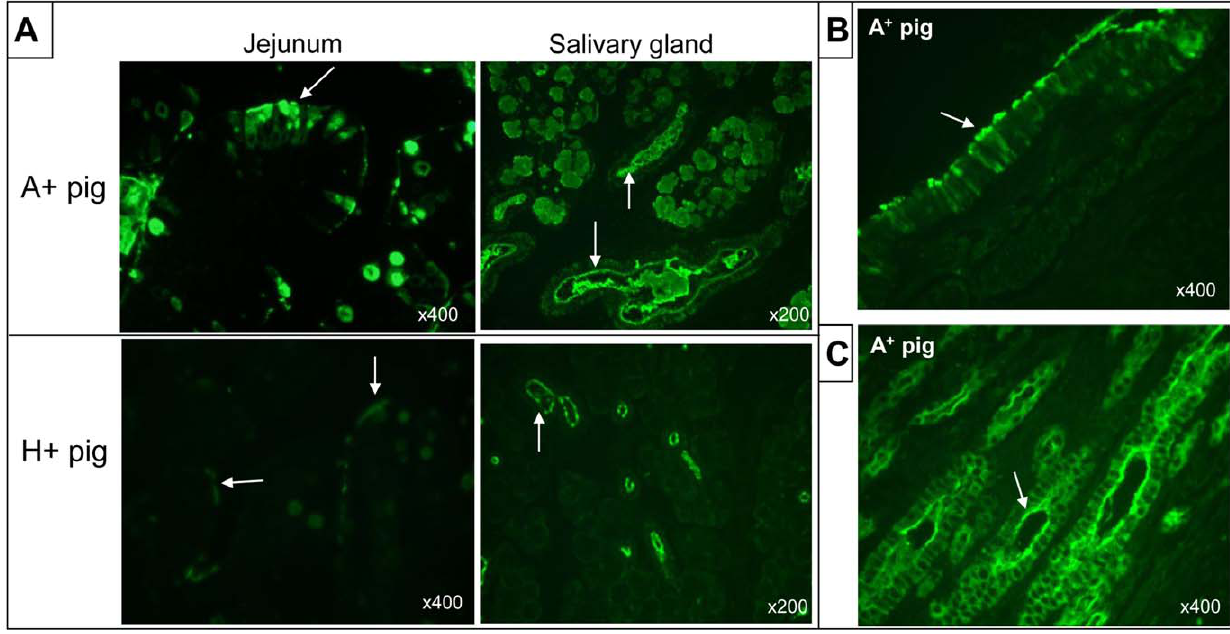
Figure 4. Insitu expression of histo-blood group antigens in Gn pigs. ( A ) Jejunum and salivary gland of A + or H + pigs, expressing large amounts of HBGA antigens (arrows). ( B ) Bronchus of a representative A + pig, expressing large amounts of A antigens on the surface or in the cytoplasm of bronchial epithelial cells. ( C ) Renal tubule of a representative A + pig, expressing large amounts of A antigens on the surface or in the cytoplasm of renal tubular epithelial cells. Original magnifications, x200 or x400, are indicated at the bottom of each picture.